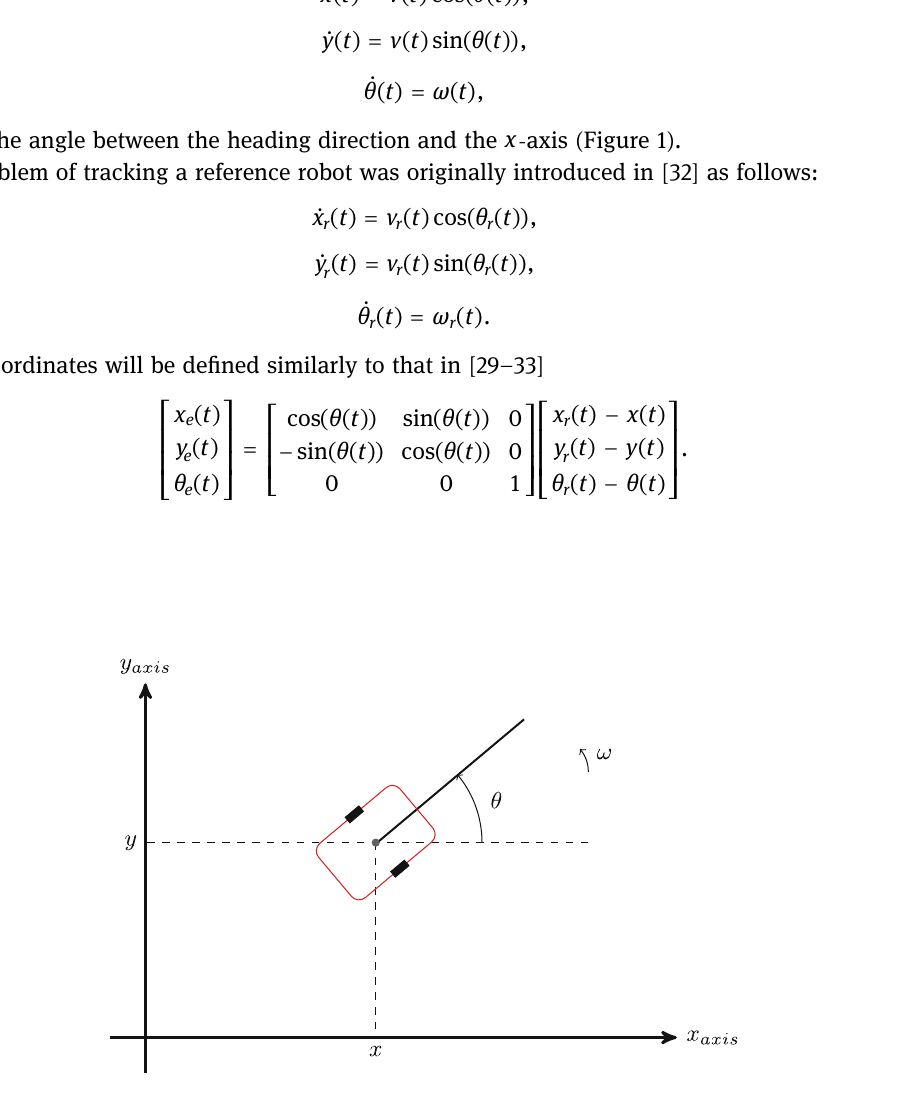
Figure 1: Wheeled robot